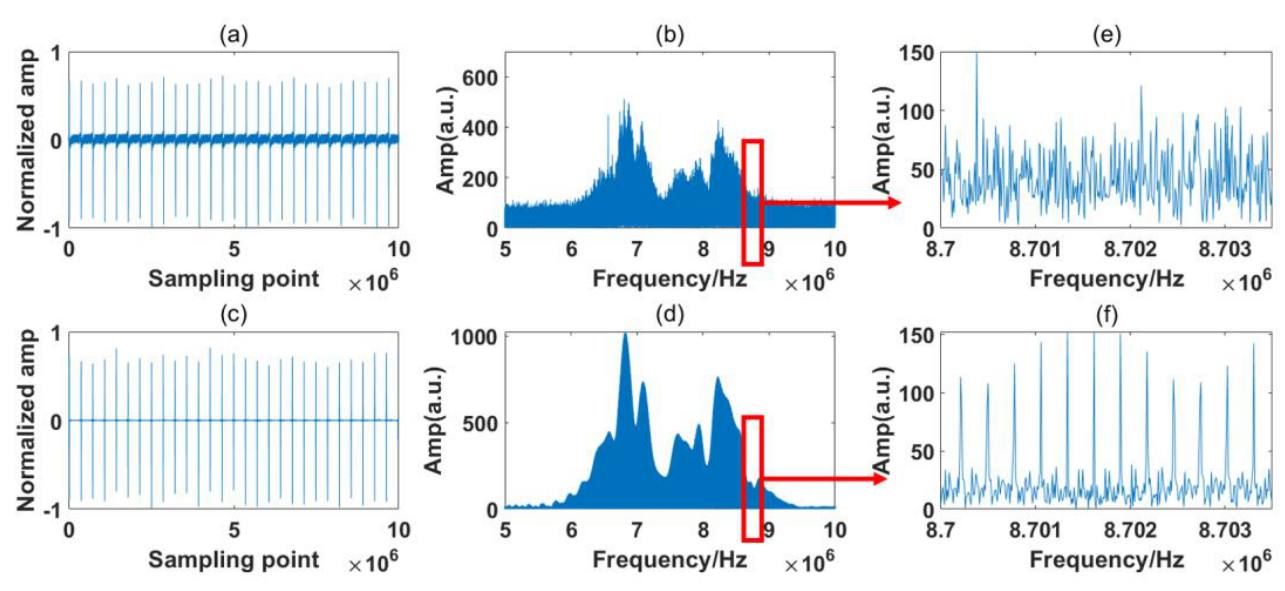
Figure 13. Experiment of the signal path signal. ( a ) Raw time domain signal; ( b ) raw frequency domain signal; ( c ) corrected time domain signal; ( d ) corrected frequency domain signal; ( e ) Magnified view of red rectangle shown in ( b ); ( f ) Magnified view of red rectangle shown in ( d ).